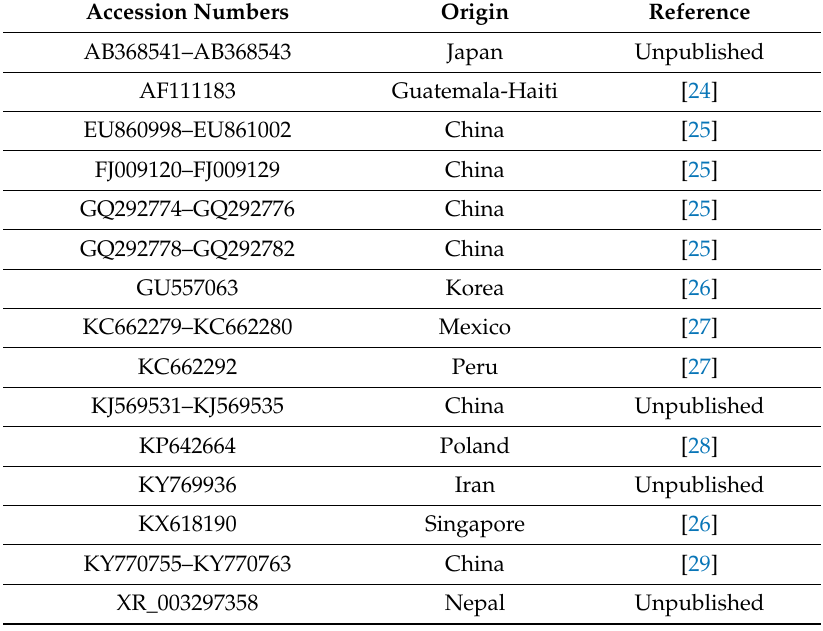
Table 1. Accession numbers of the downloaded sequences from the GenBank database used for the phylogenetic